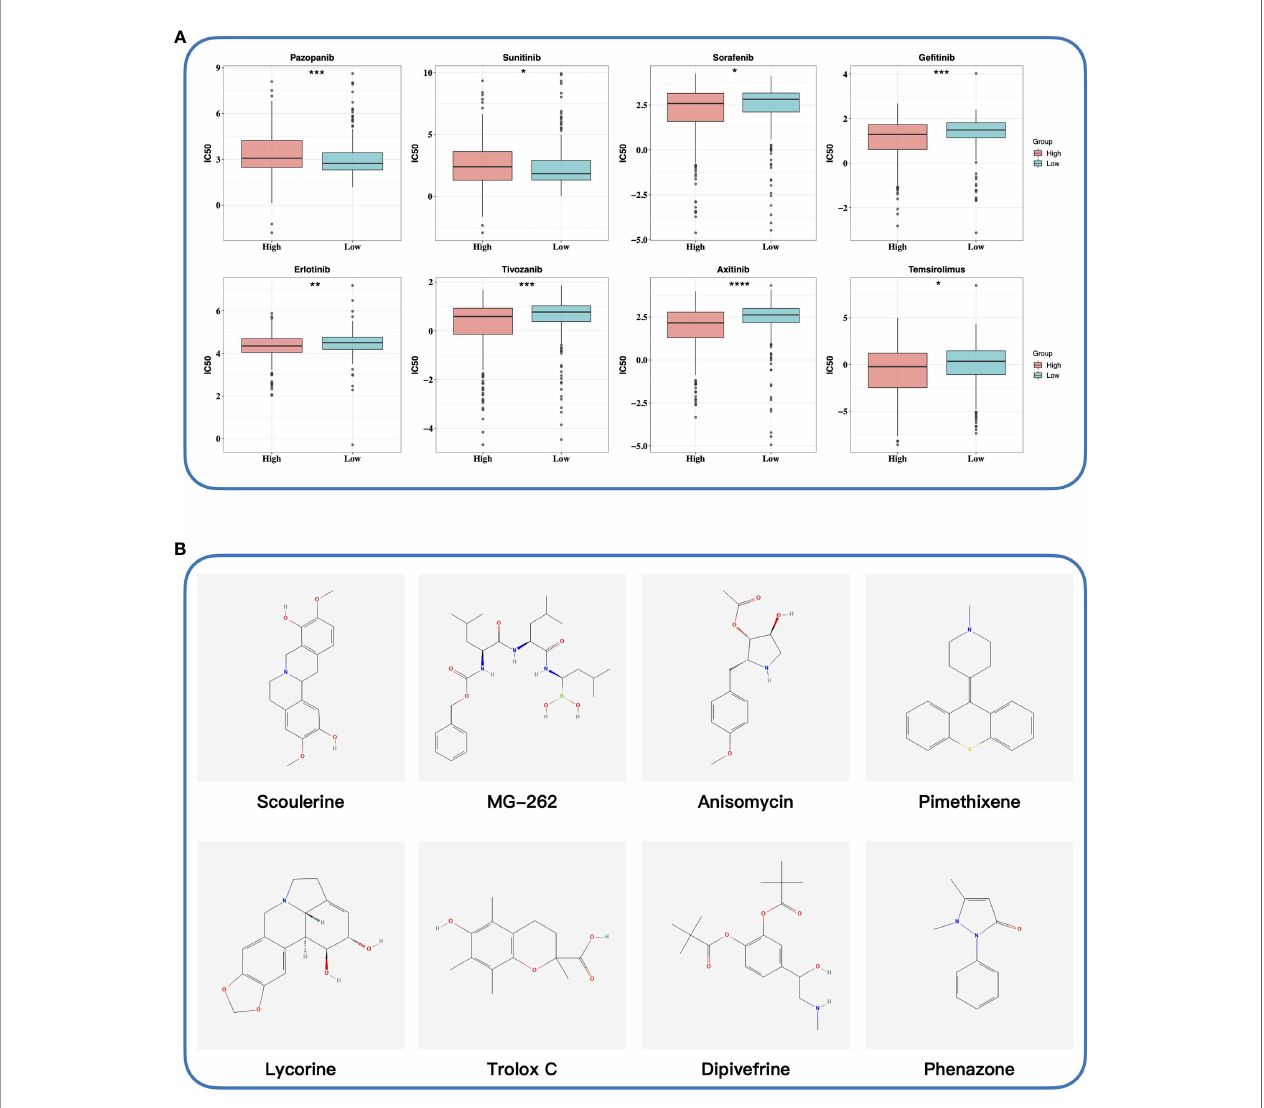
FIGURE 10 | Exploring potential drugs. (A) Predicting half-maximal inhibitory concentration values of eight common chemotherapy drugs based on the GDSC database. (B) Identifying potential small-molecule drugs based on DEGs by the cMAP database. The 2D structures of top 10 small-molecule drugs were presented. IC50, half-maximal inhibitory concentration; GDSC database, Genomics of Drug Sensitivity in Cancer database; cMAP database, the connectivity map database. * 0.01 < p < 0.05; ** 0.001 < p < 0.01; *** 0.0001 < p < 0.001; **** p <